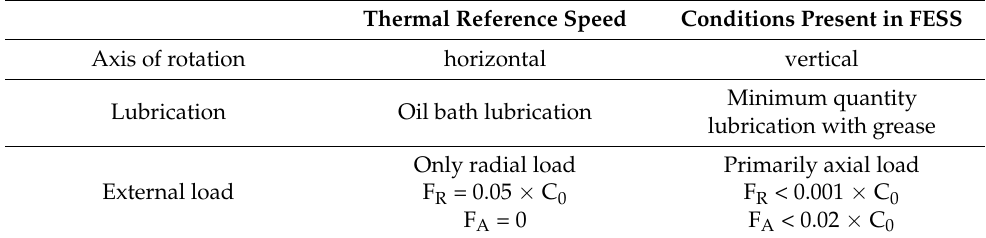
Table 5. Comparison of basic conditions in FESS and what the thermal reference speed is based on.